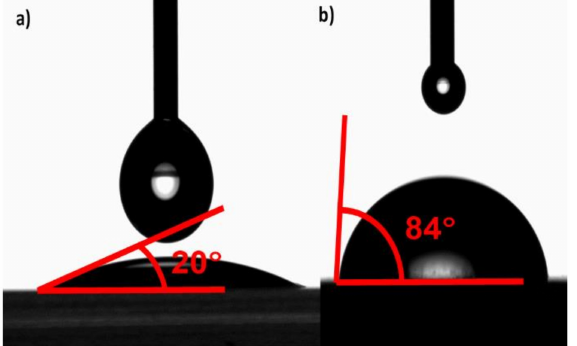
Figure 3. Droplet of water placed on the gate dielectric without a BQMI layer ( a ) and on a dielectric surface coated with BQMI compound 3 ( b